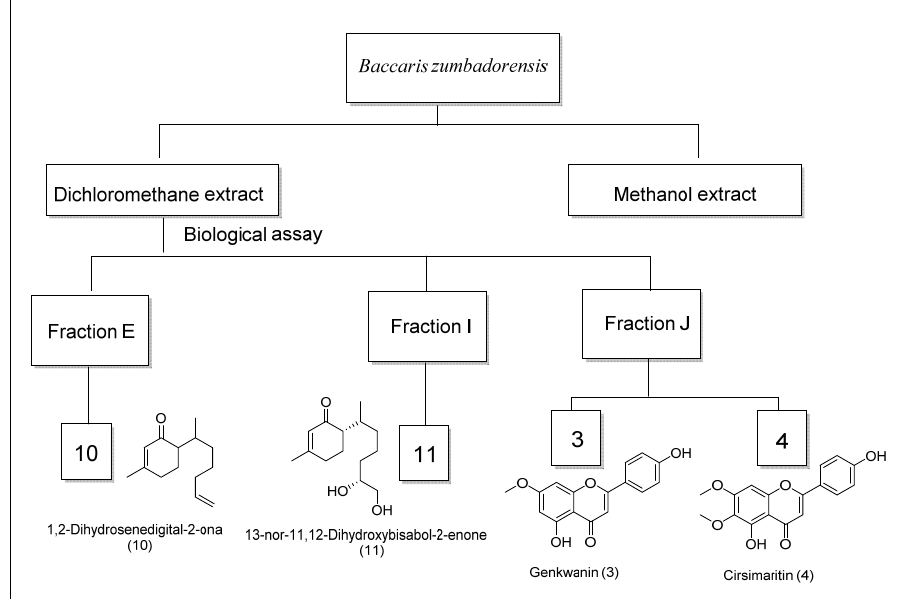
Figure 3. Scheme of the bio-guided isolated compounds from Baccharis Zumbadorensis .